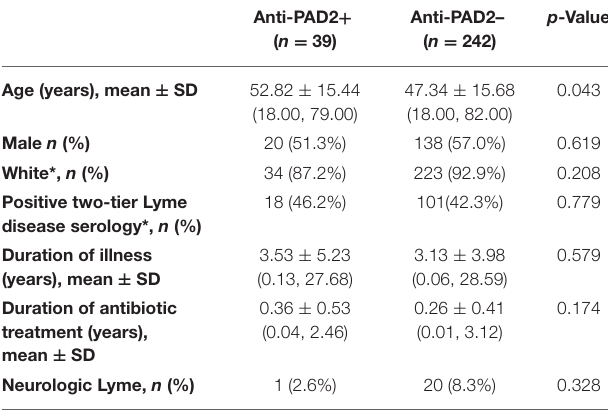
TABLE 3 | Characteristics of people with PTLD according to anti-PAD2 antibody